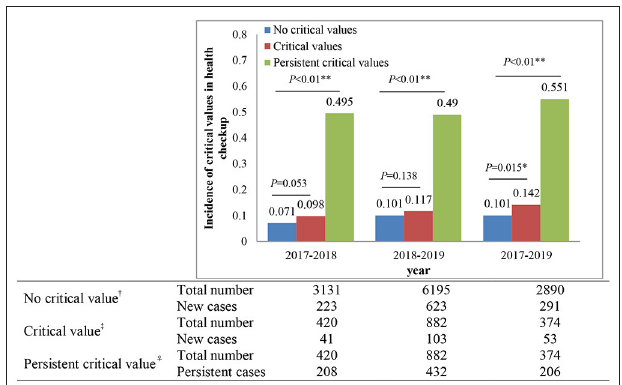
FIGURE 5 | The incidence of emerging and persistent critical values for the † participants with follow-up physical examination. Denotes no critical value in the previous year but new critical values in the next year, ‡ denotes critical values in the previous year and new critical values in the next year, and ♀ denotes critical values in the previous year and the next year. *Denotes a statistically significant difference ( P < 0.05), **denotes a statistically significant difference ( P <